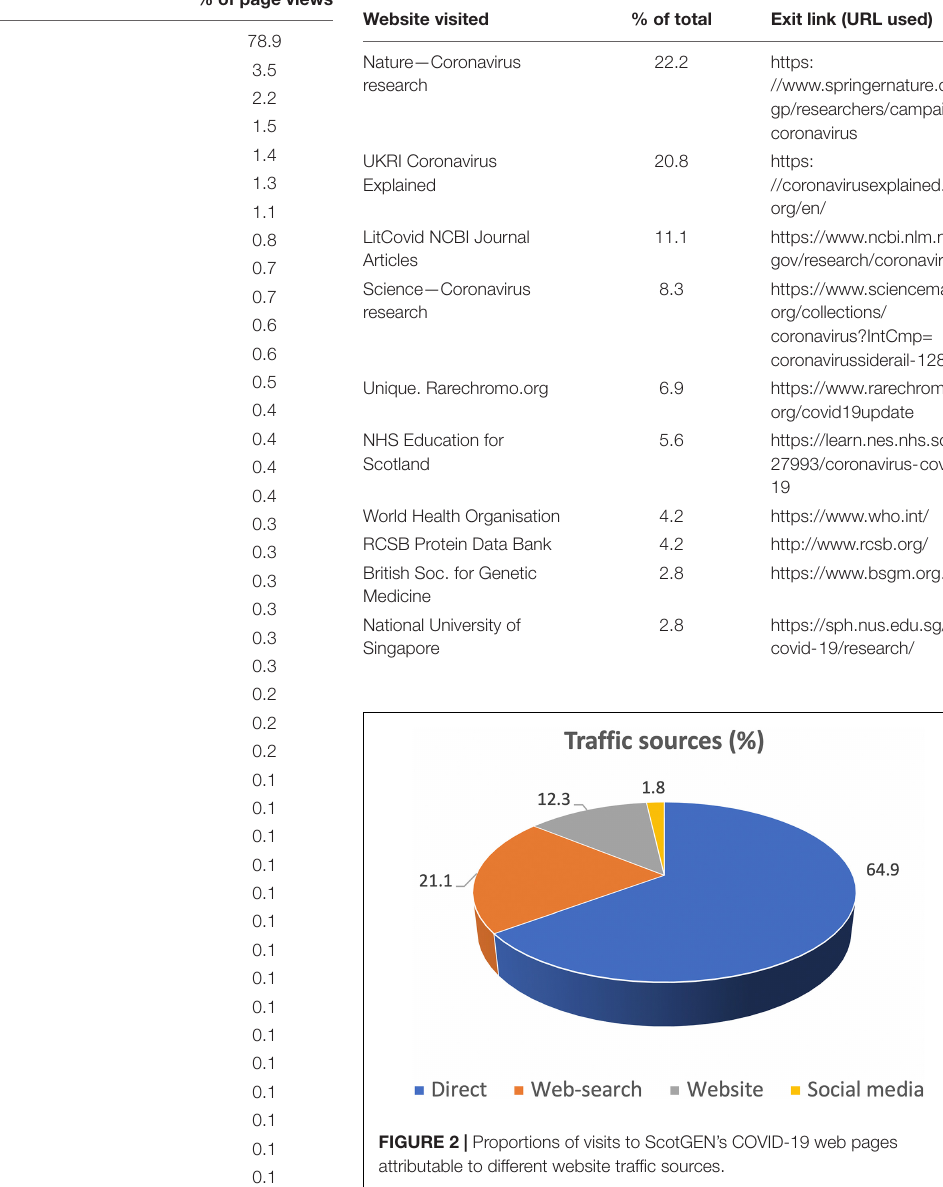
TABLE 4 | Names and URLs of the 10 most frequently used exit links from the new COVID-19 ScotGEN pages, together with the respective proportions of the total visits to external websites.